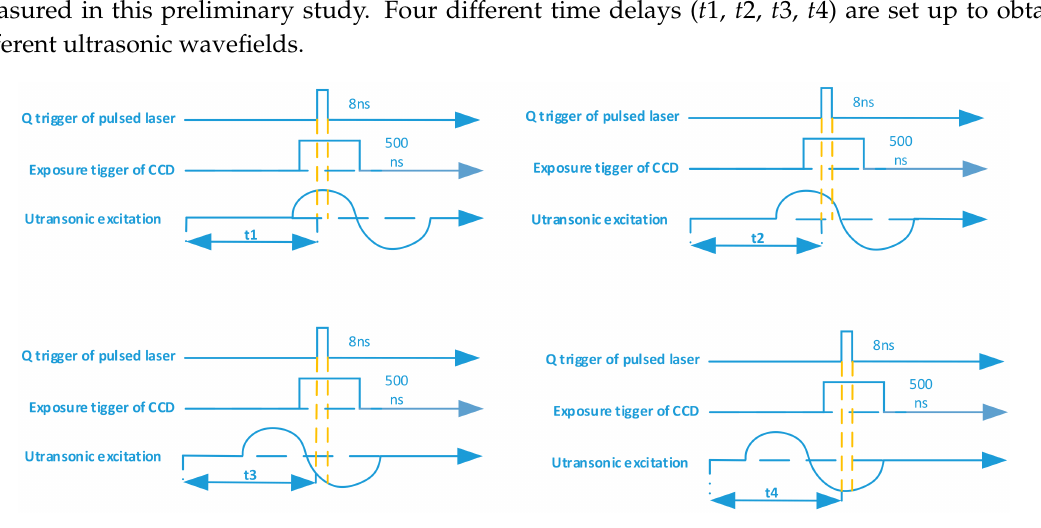
Figure 14. Synchronous control timing diagram in the